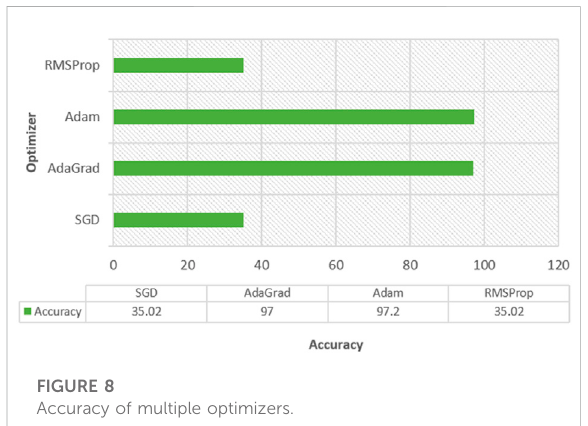
FIGURE 8 Accuracy of multiple optimizers.